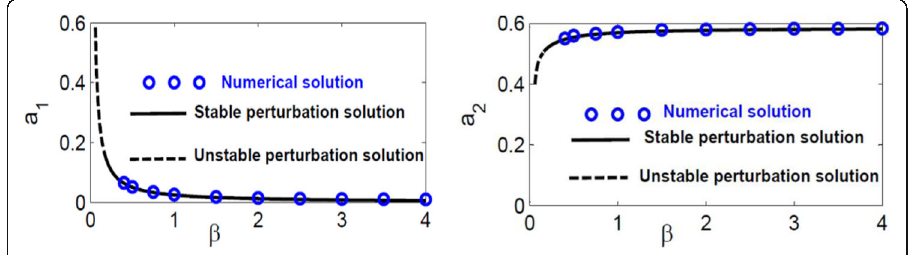
Fig. 18 Comparison between RK and MSP methods at Ω 1 ≅ ω 1 , Ω 2 ≅ 2 ω 1 , ω 1 ≅ 3 ω